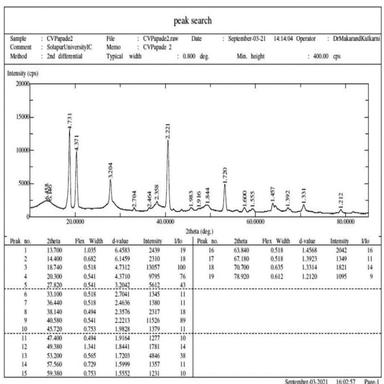
XRD analysis of nanoparticles Al2O3.